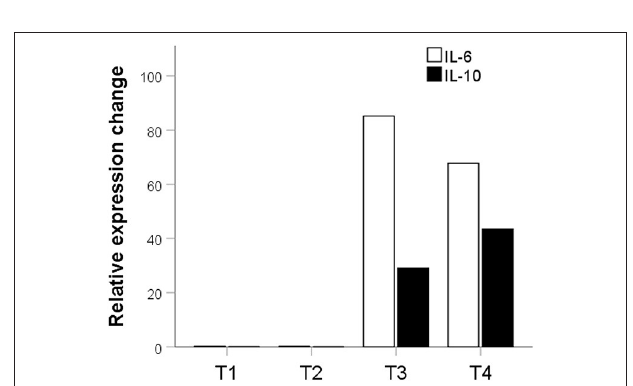
FIGURE 5 | Fold expression difference of IL-6 and Il-10 in groups treated with probiotics relative to the control group. The description is given in the text. T1, group treated with B. subtilis KATMIRA1933; T2, group treated with B. subtilis KB16; T3, group treated with B. subtilis KB41; T4, group treated with B. amyloliquefaciens